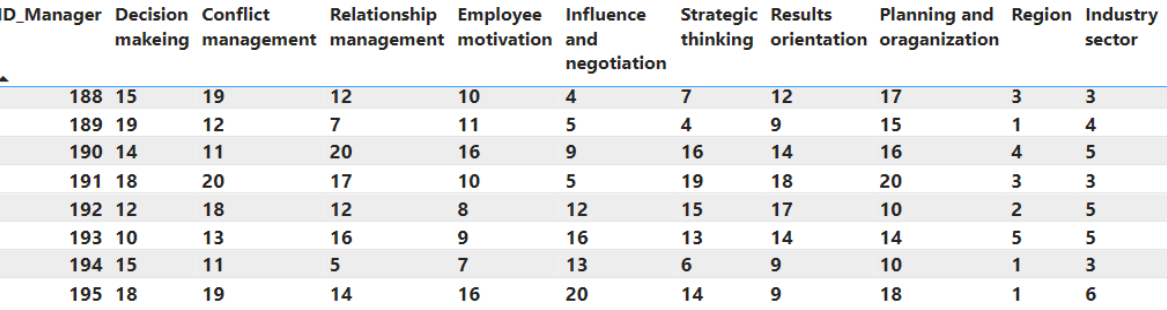
Figure 8. O21. Dataset. Partial